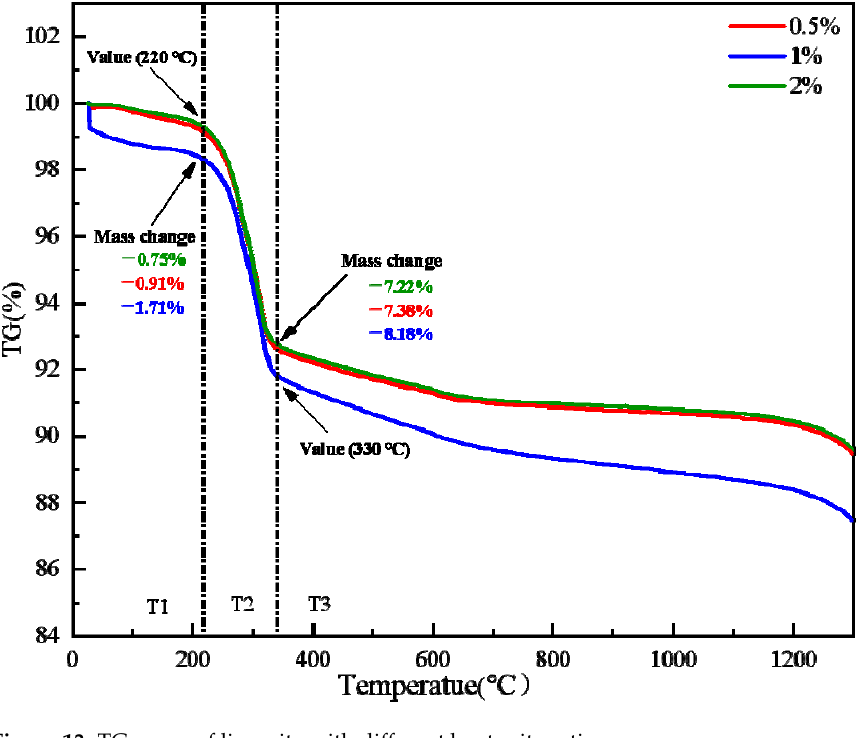
Figure 13. TG curve of limonite with different bentonite ratio.